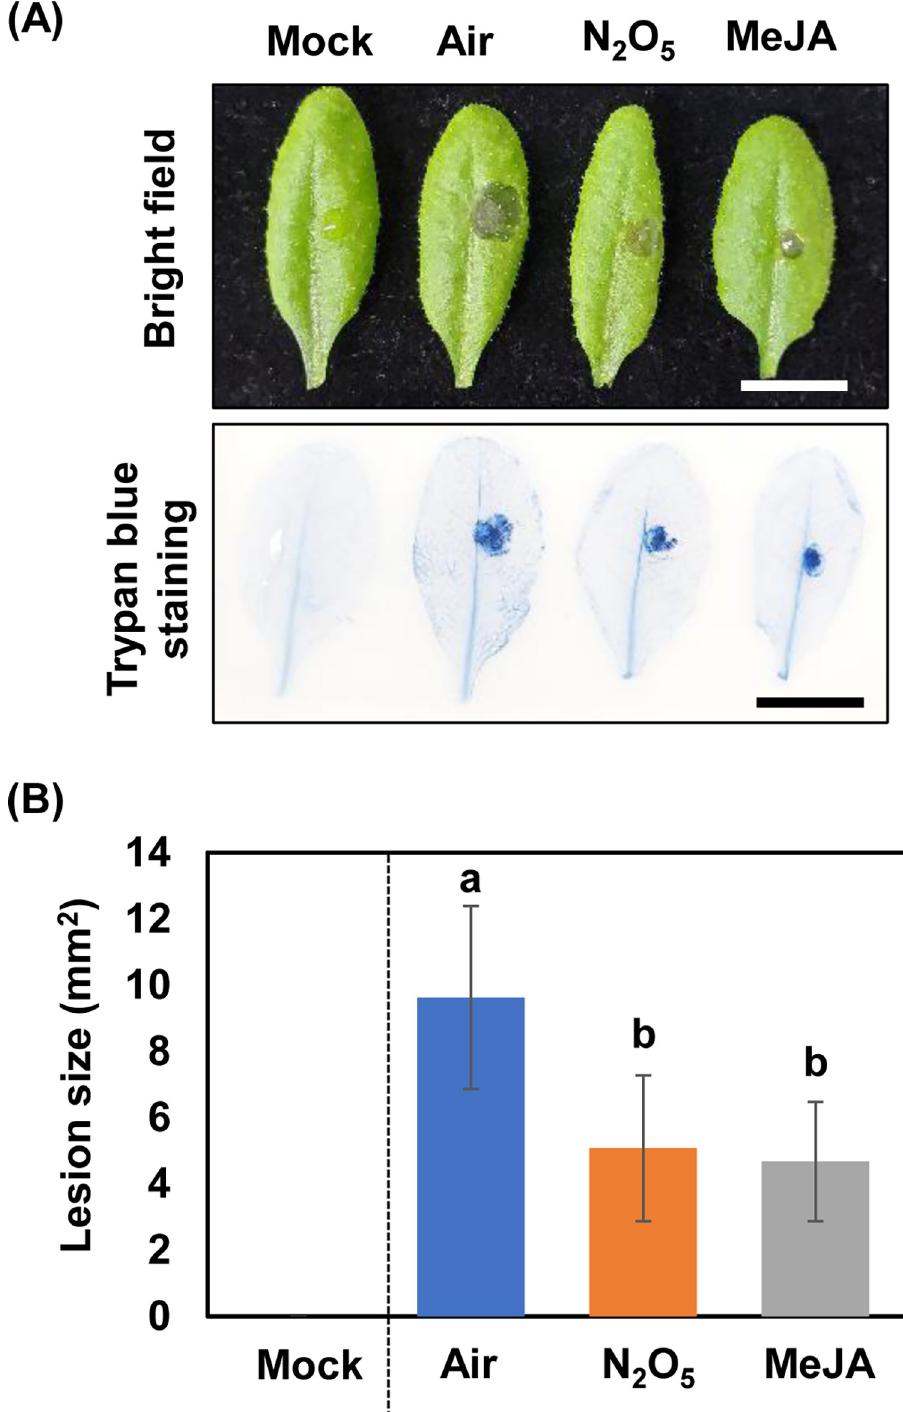
Fig 2. Induction of Botrytis cinerea resistance in Arabidopsis plants by N 2 O 5 gas exposure. (A) Arabidopsis plants exposed to N 2 O 5 gas were inoculated with B . cinerea . Scale bar is 1 cm. (B) Areas of the lesions at 2 days after B . cinerea inoculation were measured and the mean ( ± standard deviation) is shown. Different letters indicate significant differences according to the Tukey–Kramer test (n = 11–12, P <